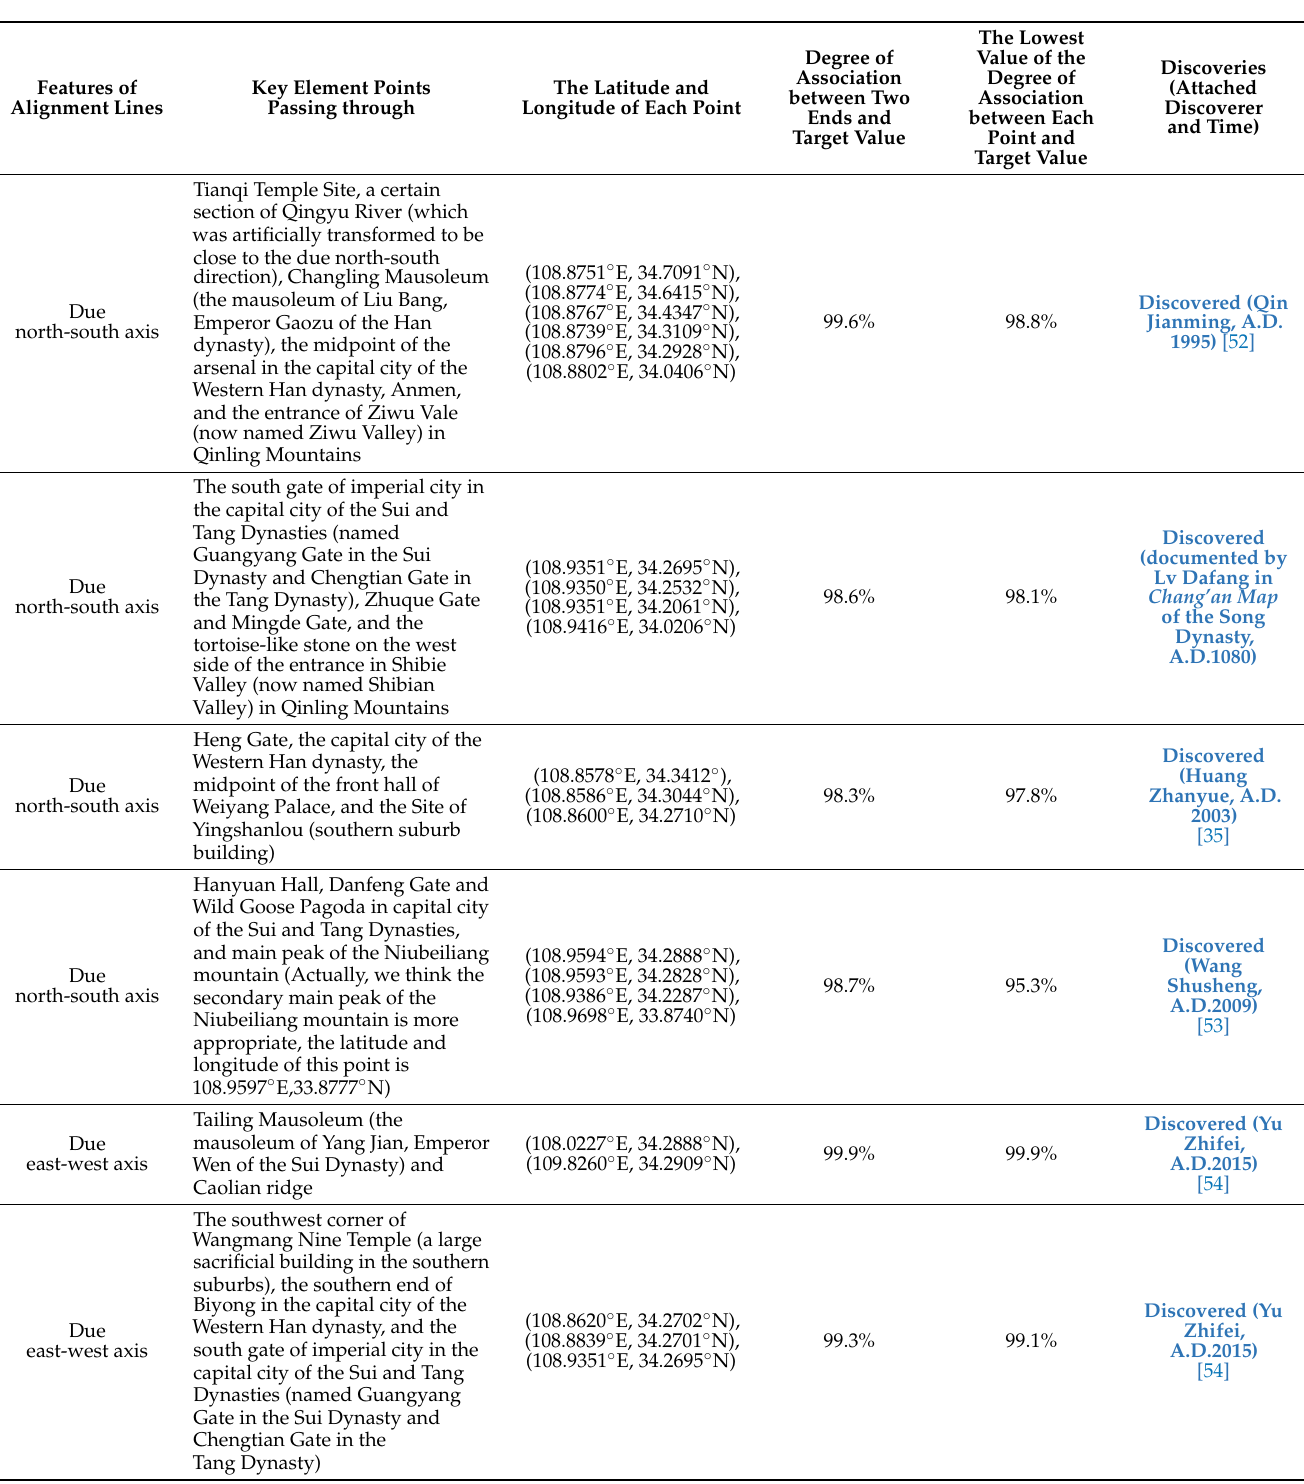
Table 3. List of the analysis results of the spatial relationship between Chinese capitals of the Western Han dynasty as well as the Sui and Tang dynasties and the natural environment (existing